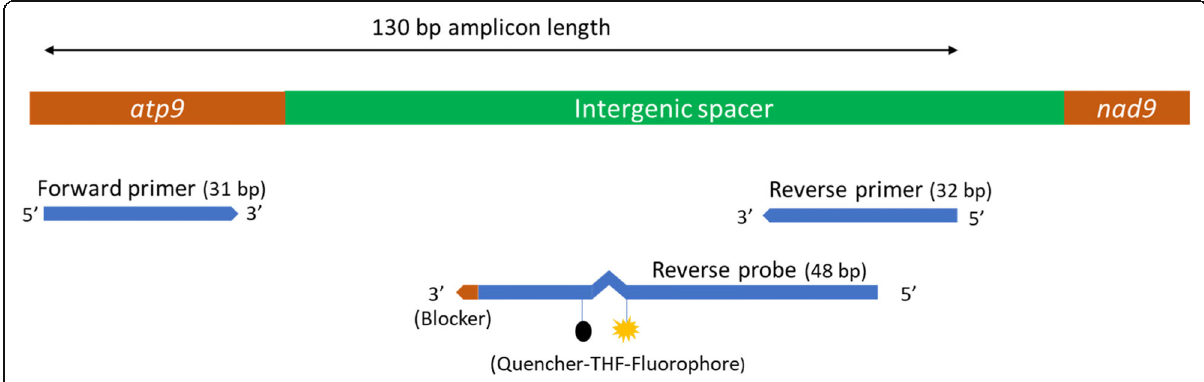
Fig. 2 Location of primers and probe in the RPA assay